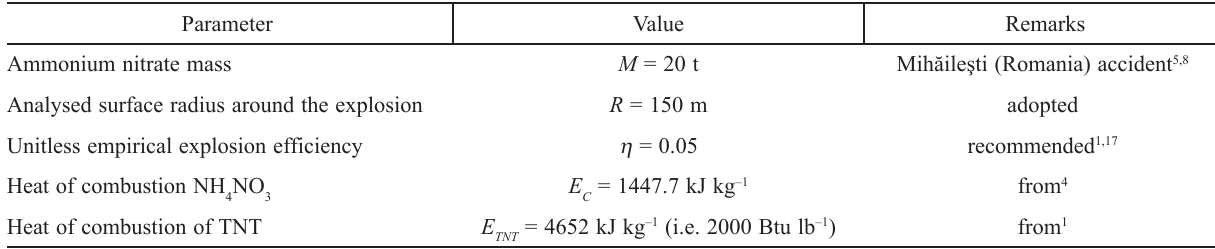
Table 5 – Simulated Mihăileşti case study input